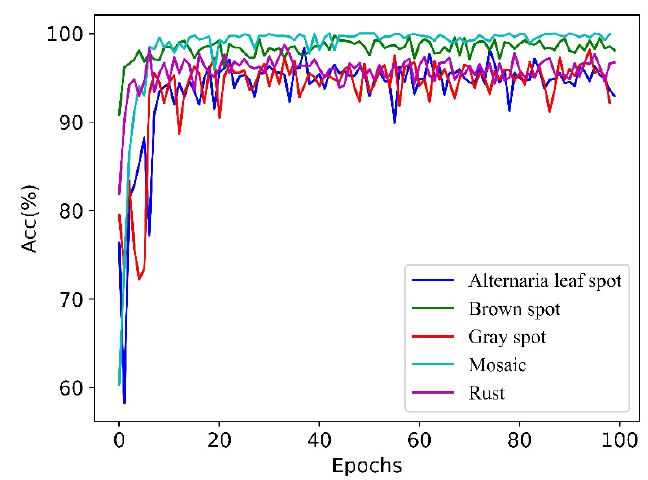
Figure 11. Comparison of verification accuracy for different types of apple diseases.